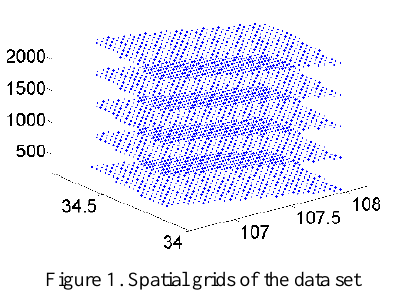
Figure 1. Spatial grids of the data set